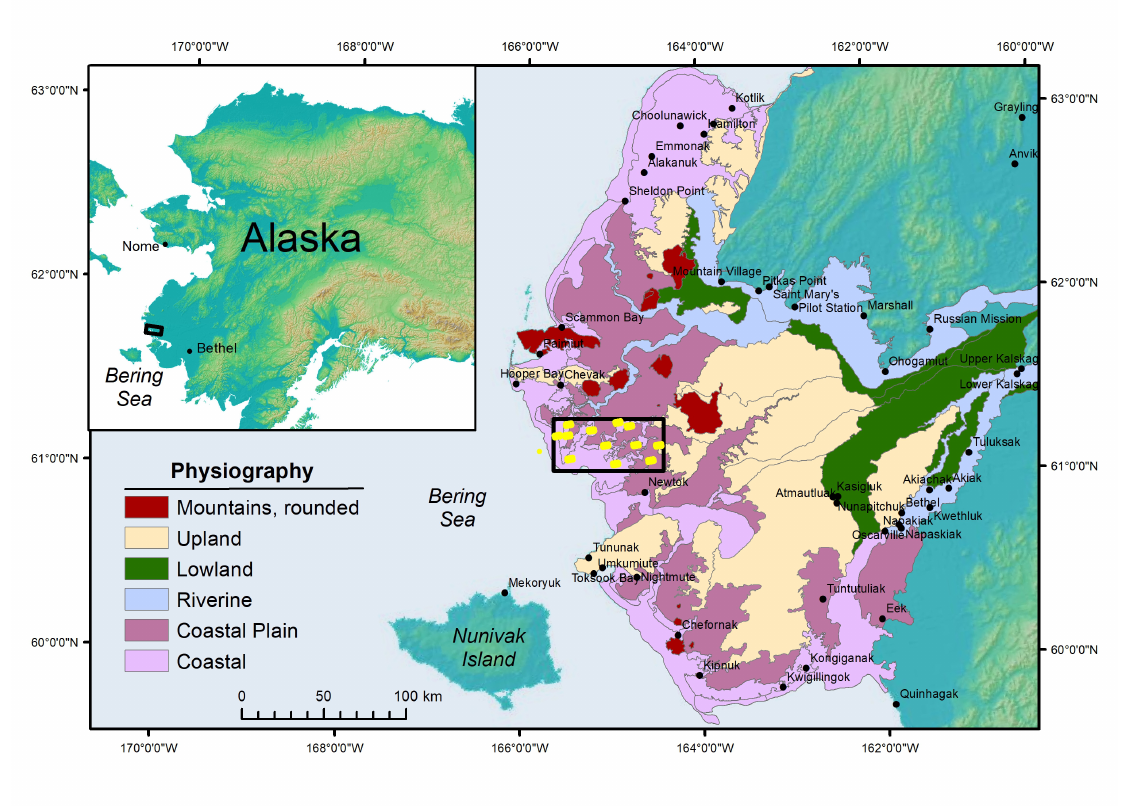
Figure 1. Location of the study area along the central coast of the Yukon-Kuskokwim Delta. The physiography of the ecological landscapes of the YKD ecoregion are shown. The sampling grids within the study area are shown in